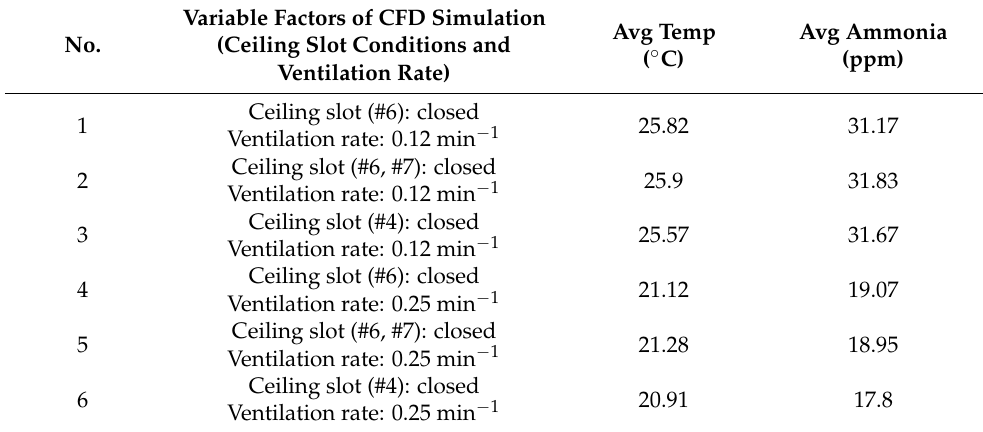
Table 7. CFD computed results of air temperature and ammonia concentration according to the opening conditions of the ceiling slots and ventilation